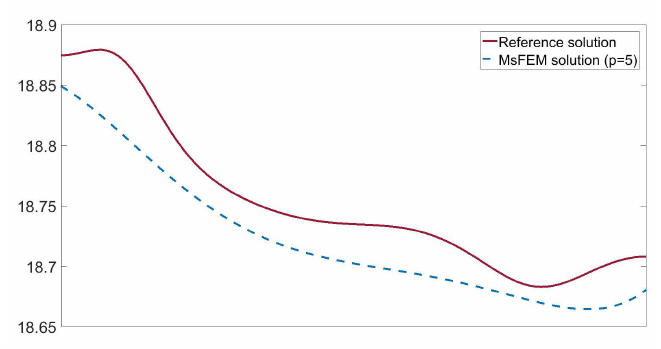
Figure 9. Temperature [°C] along the selected segment (at the half of the specimen height).